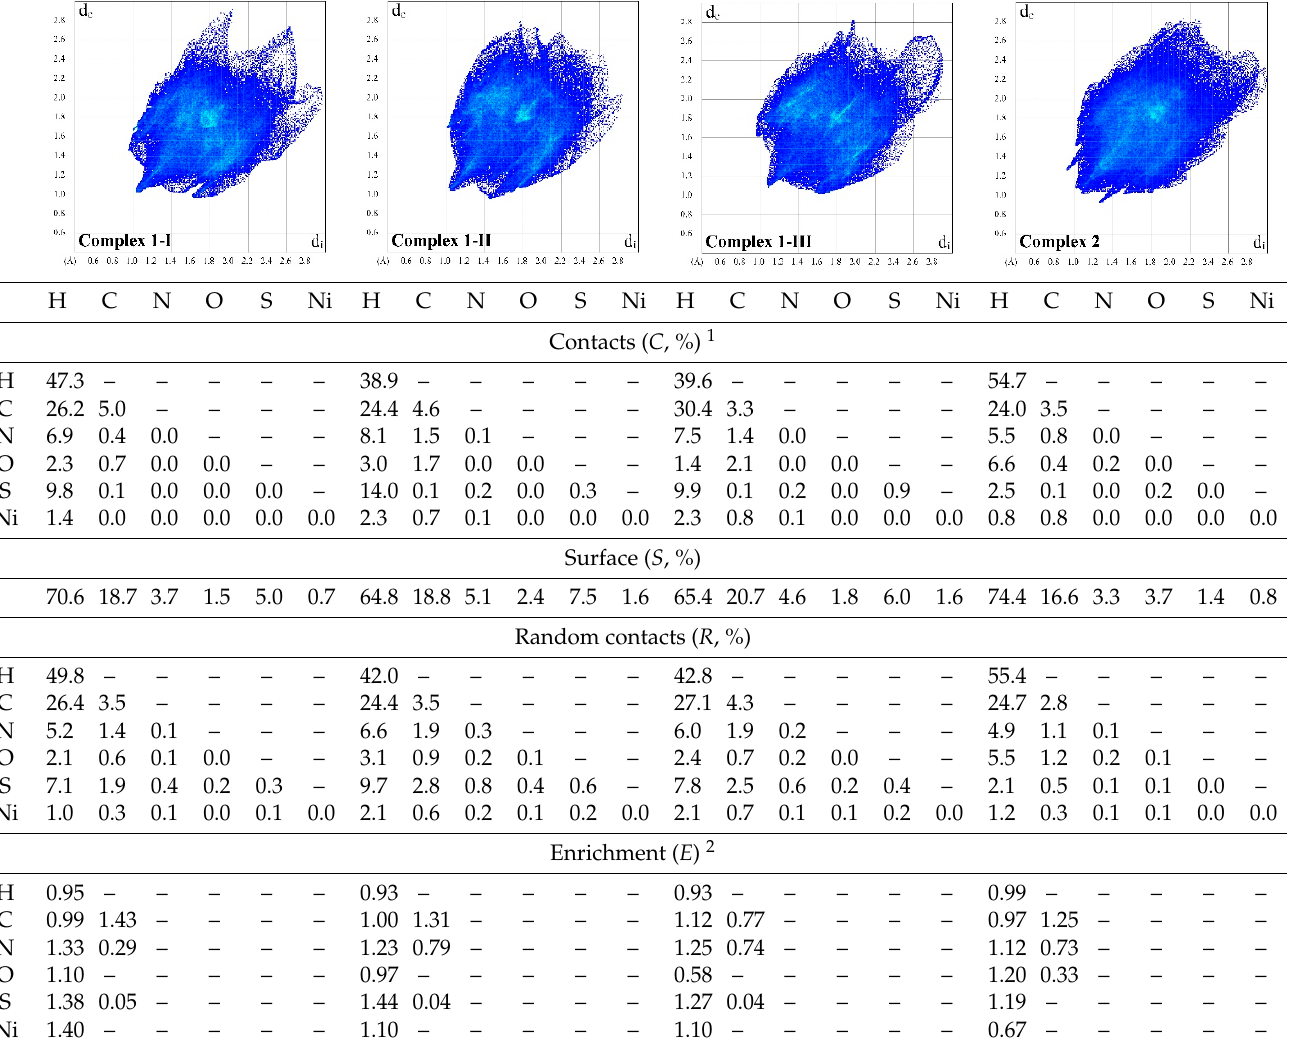
Table 5. Hirshfeld Contact Surfaces and Derived “Random Contacts” and “Enrichment Ratios” for 1-I , 1-II , 1-III , and 2 . .